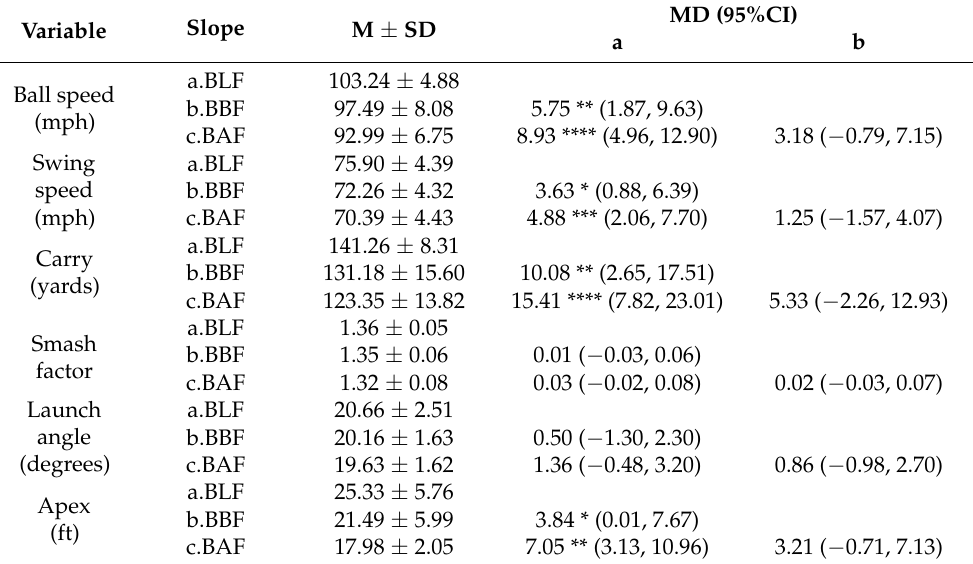
Table 7. Hit Parameter Results for BLF, BBF, and BAF measured by launch monitor (mean ± SD). Variable